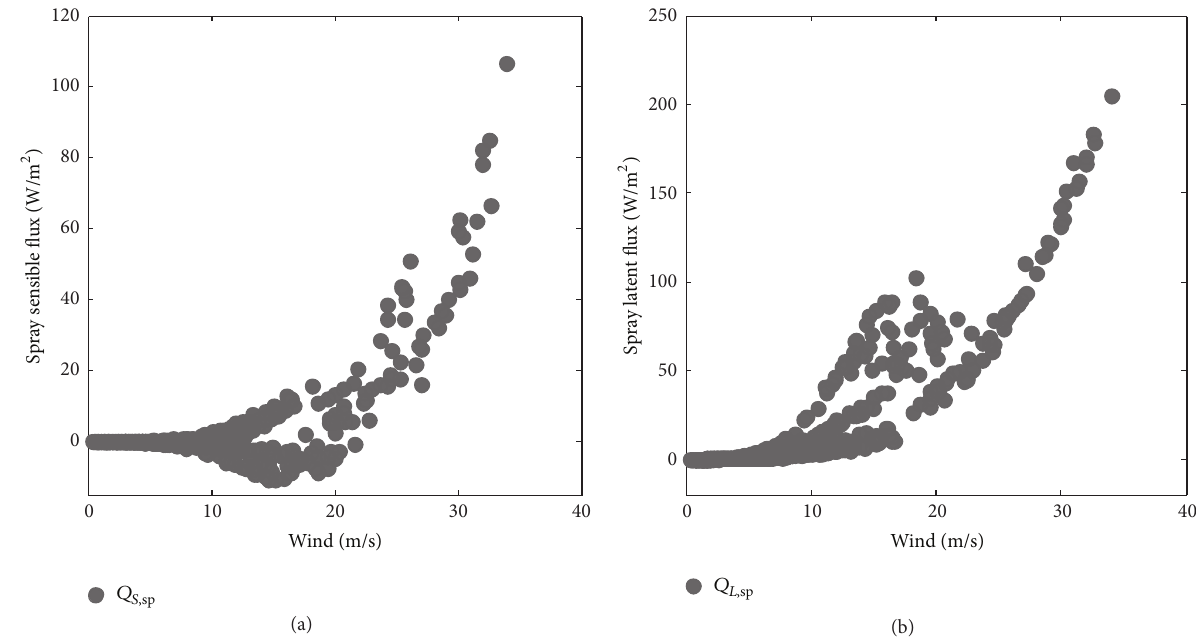
Figure 9: Sea spray induced heat fluxes. (a) Spray sensible flux 𝑄 𝑆,